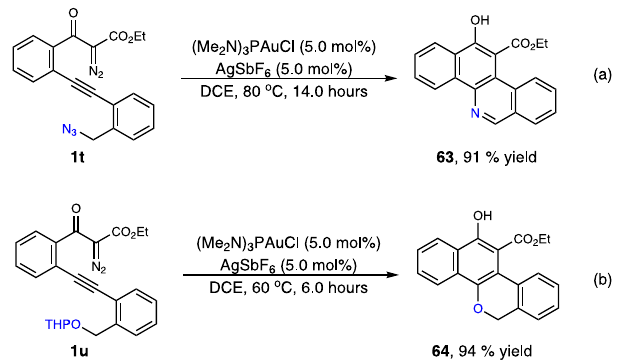
Fig. 7 Synthetic applications of current strategy. a Synthesis of benzo[ c ]